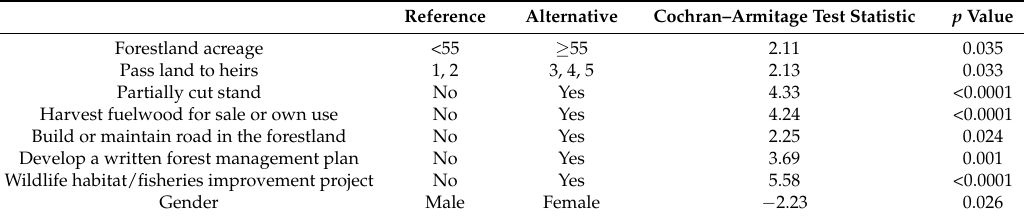
Table 2. Trend in the invasive-plant-species removal regularity and forestland owner features, management